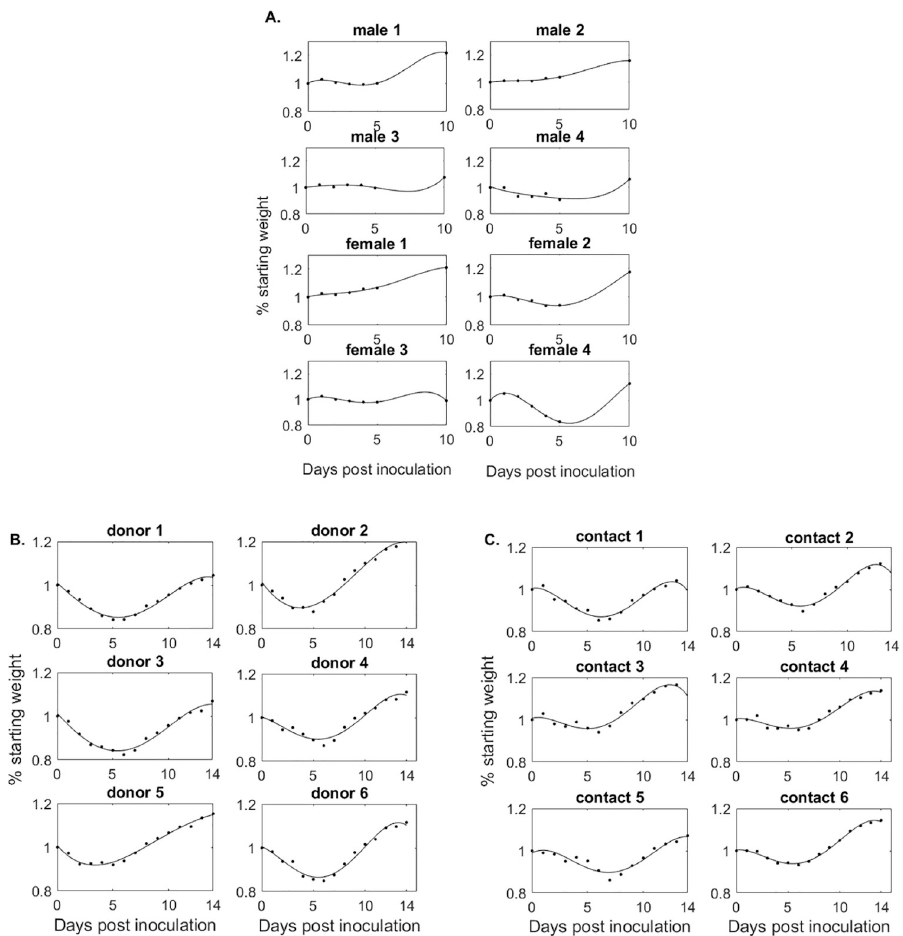
Fig 2. % Weight change from baseline over time. Weight functions (black lines) versus weight data (diamonds) in (A) males and females, (B) donors, and (C)